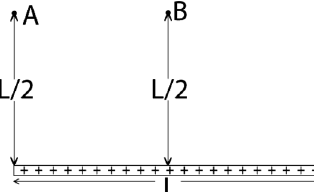
FIG. 7. A schematic diagram for the post-test question (1).